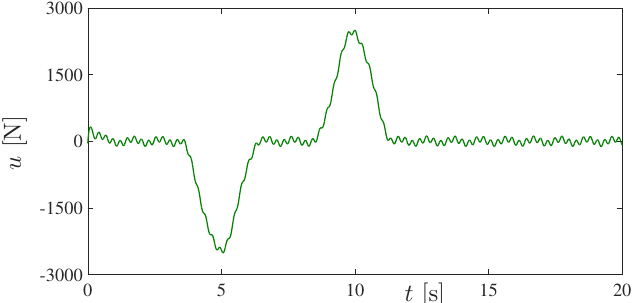
Figure 13. Active control force applied to the vehicle suspension system using measurements of velocity and disturbance